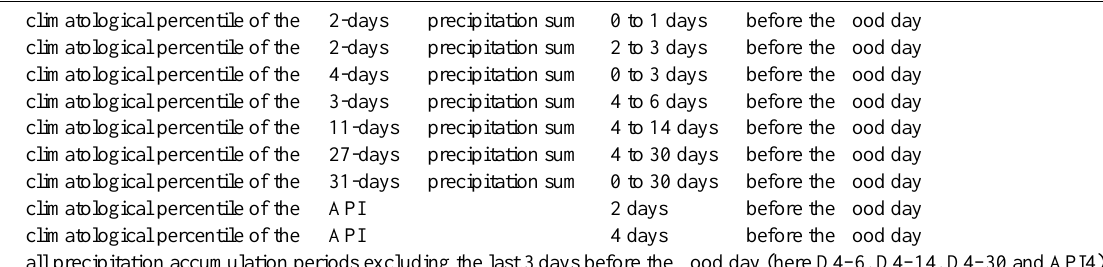
Table 1. The different precipitation accumulation periods (PAPs) used in this